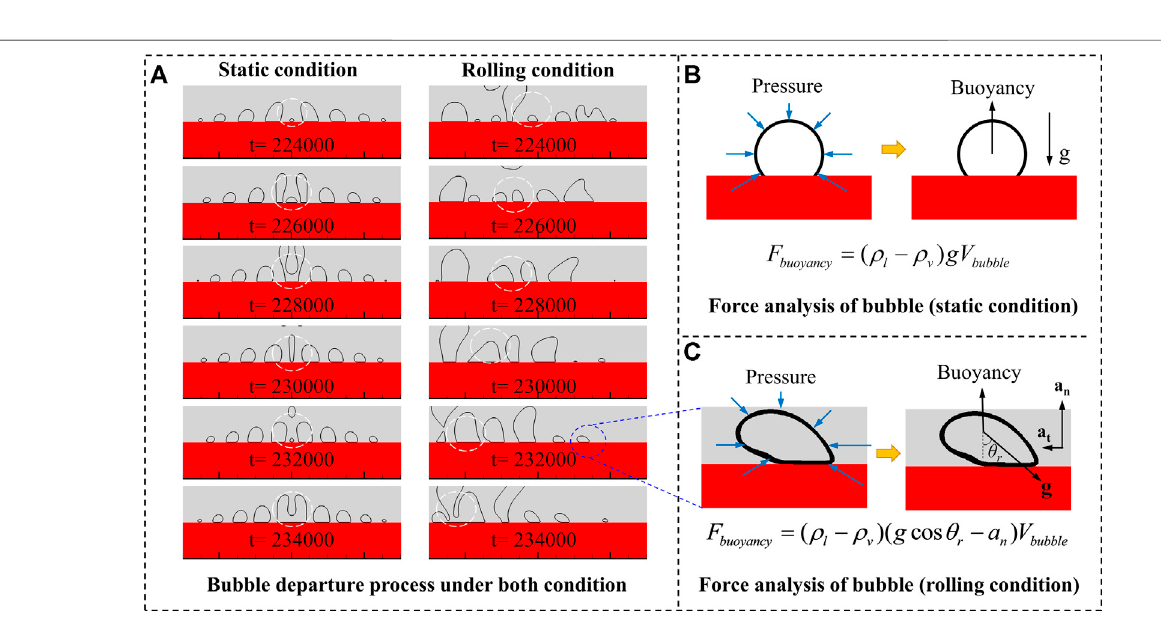
Frontiers in Energy Research |